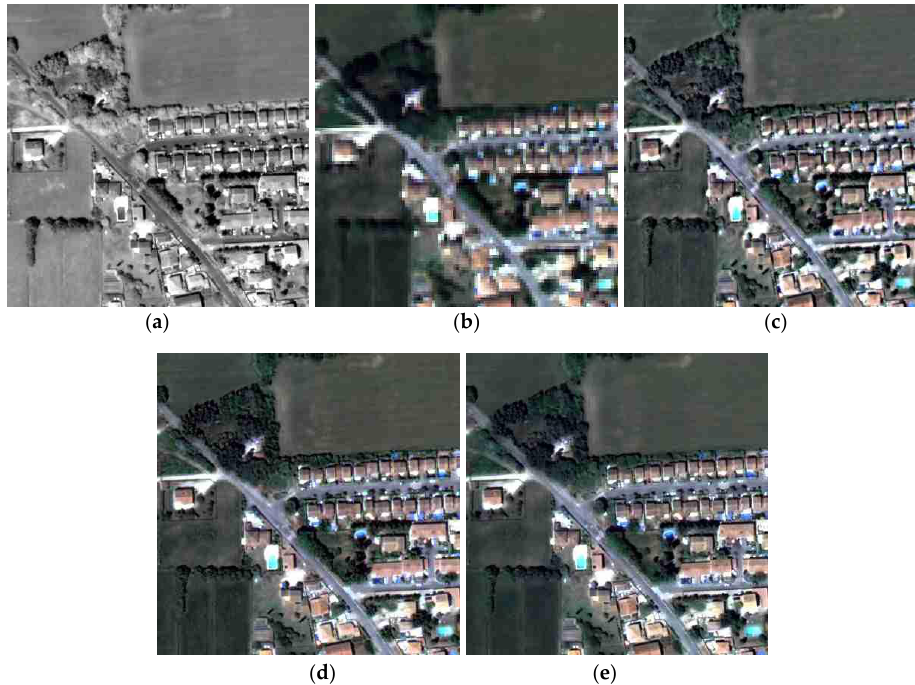
Figure 4. The details of pansharpened images according to each algorithm in the Salon region, France: ( a ) panchromatic image; ( b ) resized multispectral image; ( c ) image pansharpened by the generalized Laplacian pyramids with modulation transfer function-matched filtering (MTF-GLP) method; ( d ) image pansharpened by the Gram–Schmidt adaptive (GSA) method; ( e ) image pansharpened by the GF-based pansharpening algorithm using local injection gains based on the normalized difference vegetation index (GFNDVI) method.